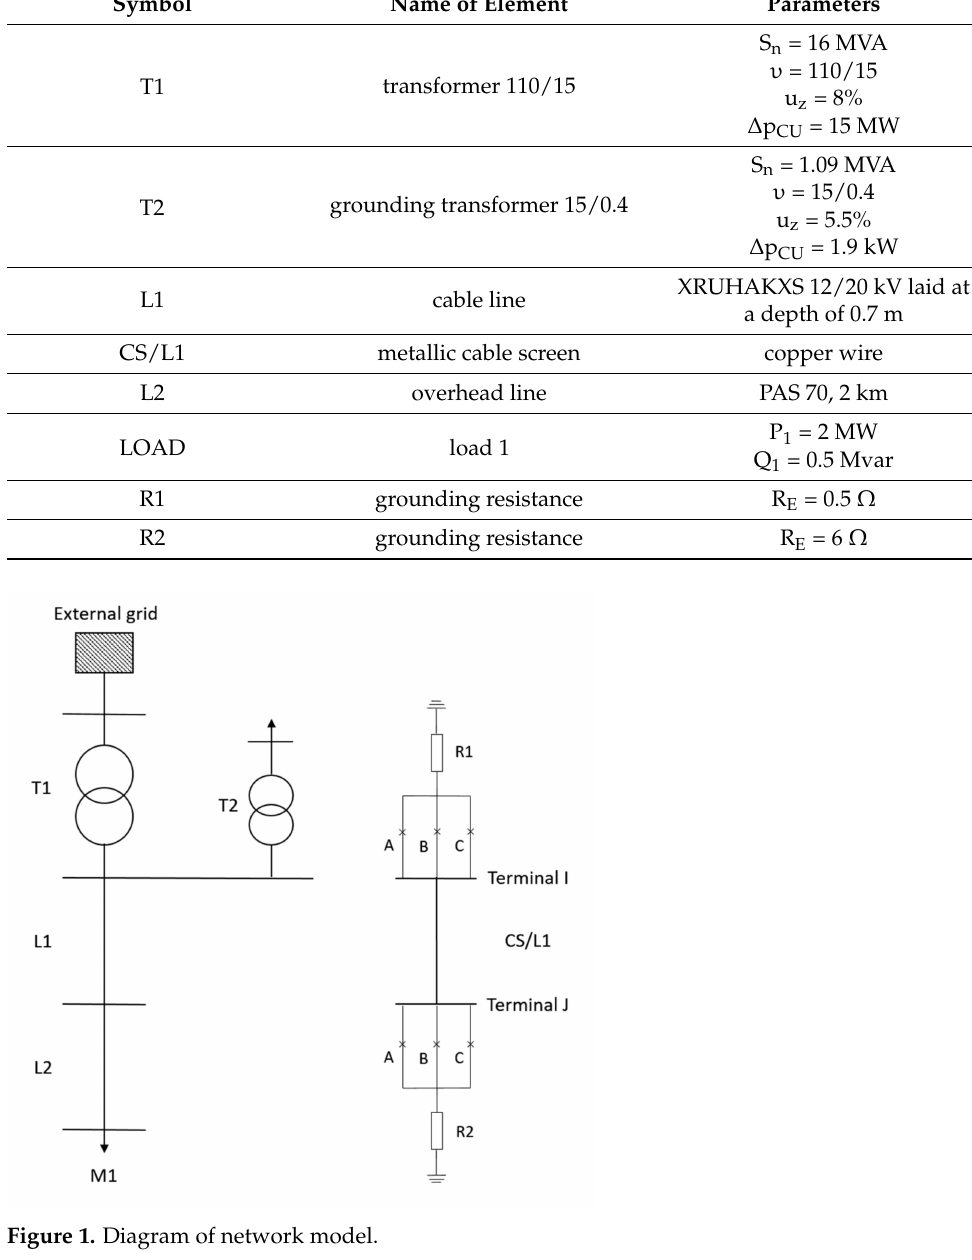
Figure 1. Diagram of network